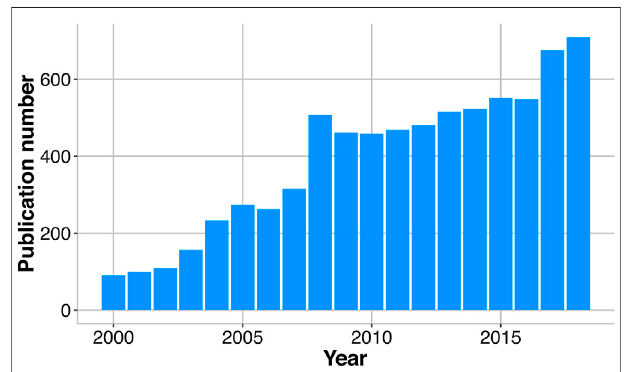
FIGURE 1 | The annual amount of verbal communication robot-related publications since the year 2000. In the past 18 years, the number of publications gradually increased, reaching a maximum in current